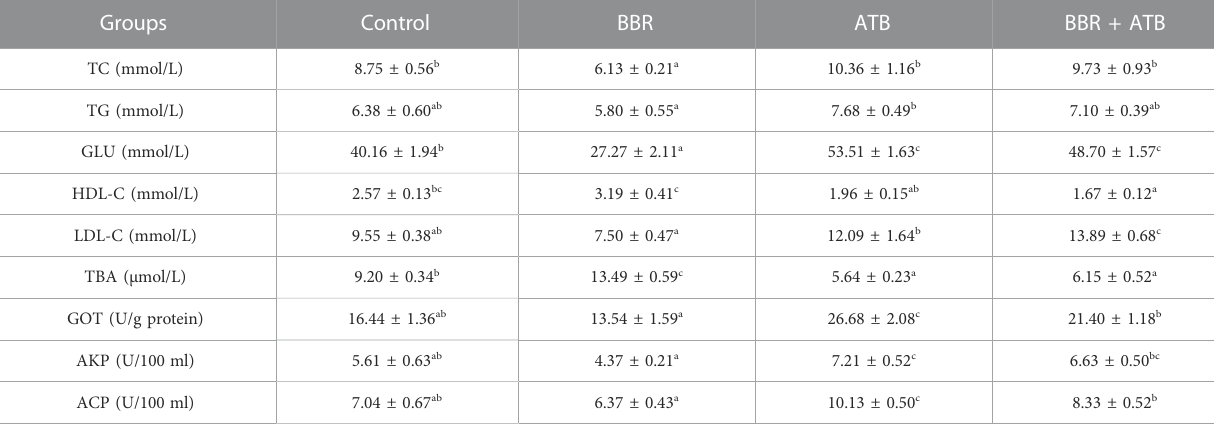
TABLE 3 Serum biochemical and enzymatic indices of largemouth bass.